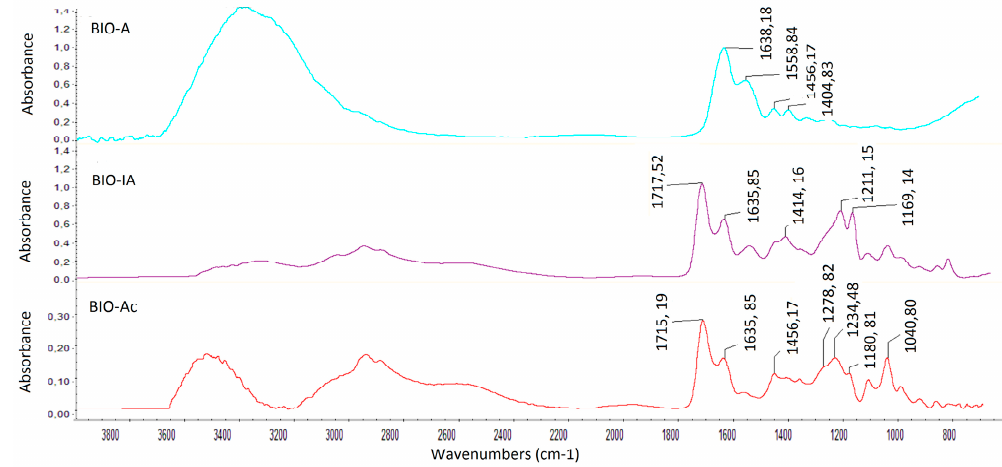
Figure 4. FTIR spectra in ATR mode of Bio-A, Bio-IA, Bio-Ac.